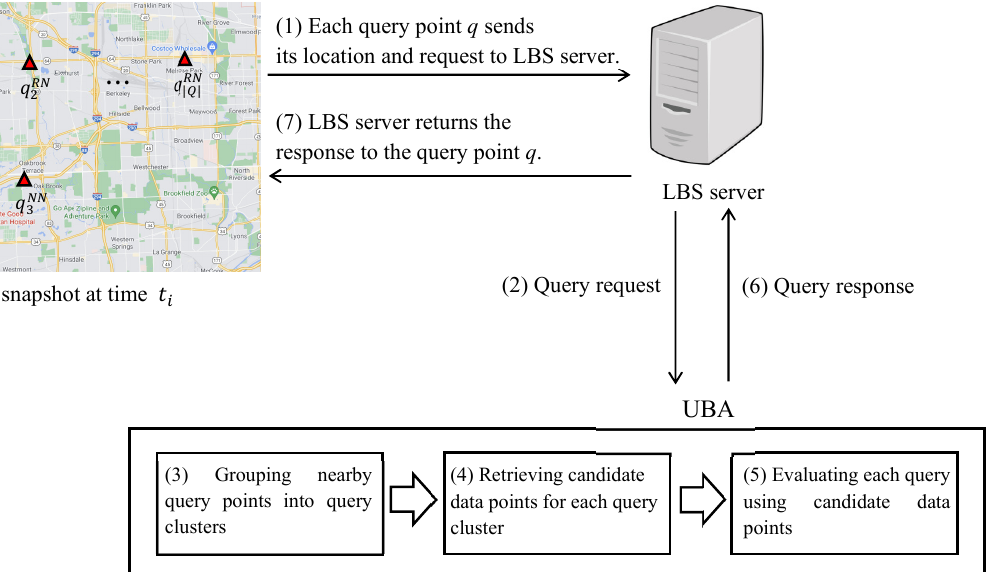
Figure 2. System diagram of UBA between query points and LBS